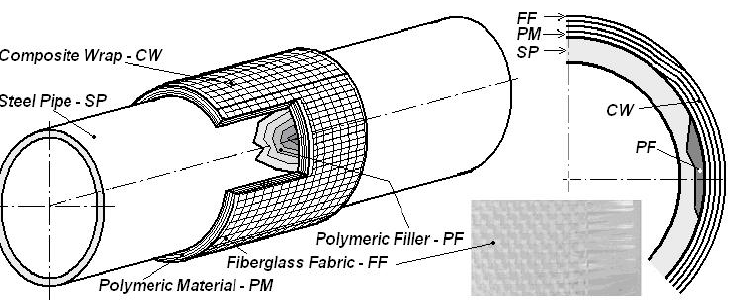
Figure 1. Structure of a wet lay ‐ up composite repair system, applied on a steel pipeline